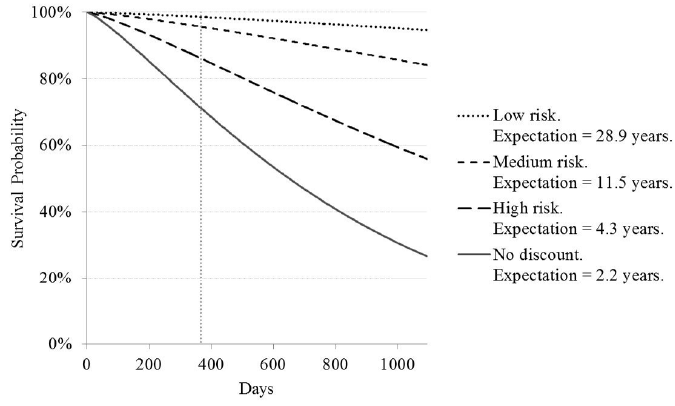
Figure 2. Survival curve for the time to the first accident at fault for men.